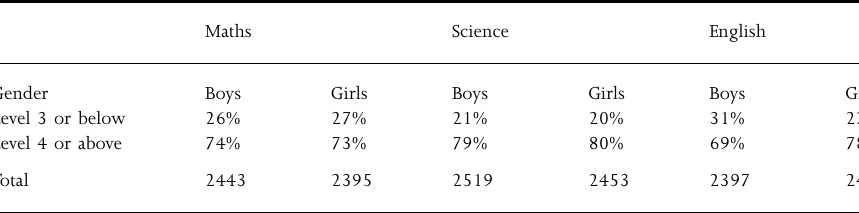
Table 2 Performance at KS2 by